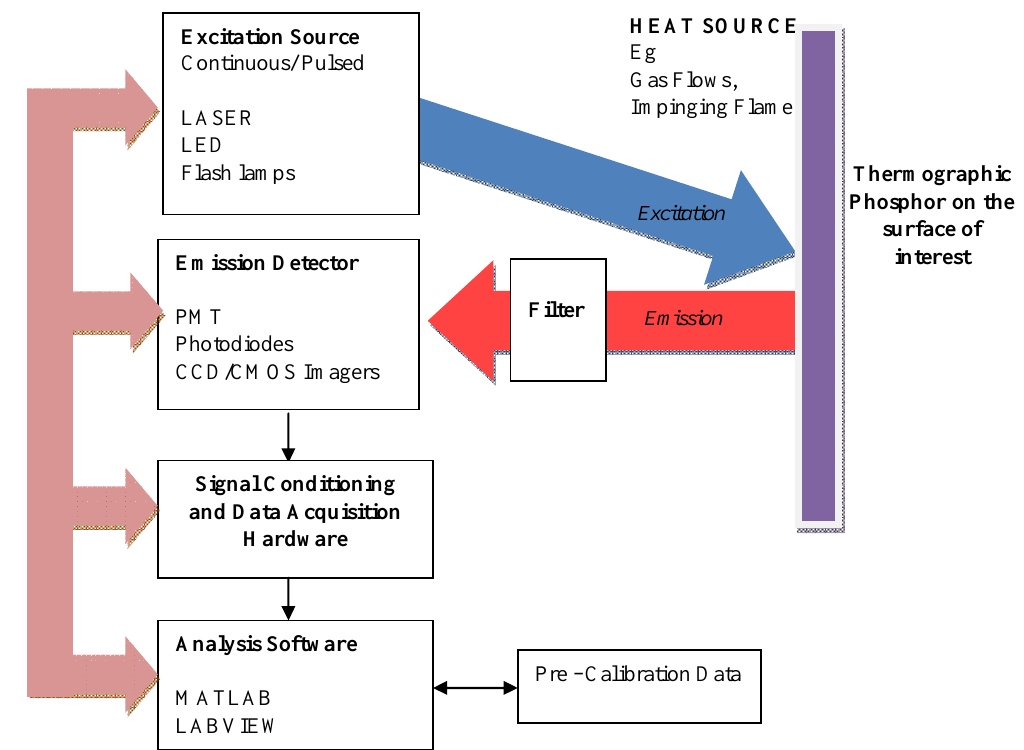
Figure 5. Generic layout for a thermographic phosphor